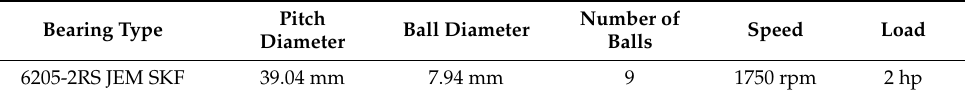
Table 3. The parameters of the rolling bearing.